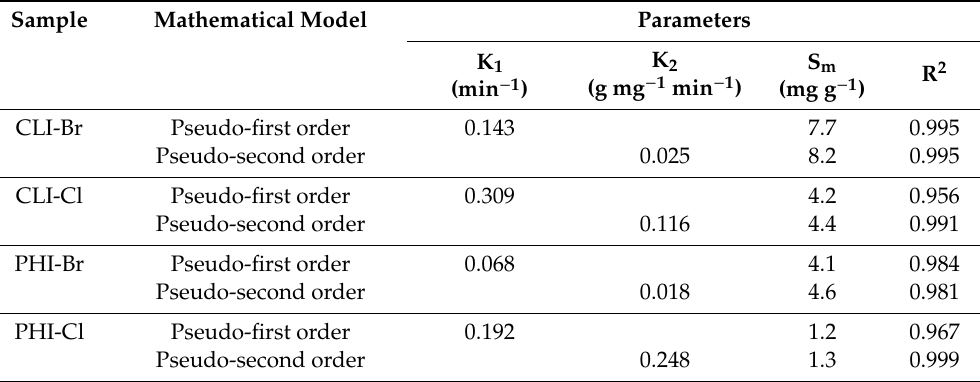
Table 3. Kinetic parameters.